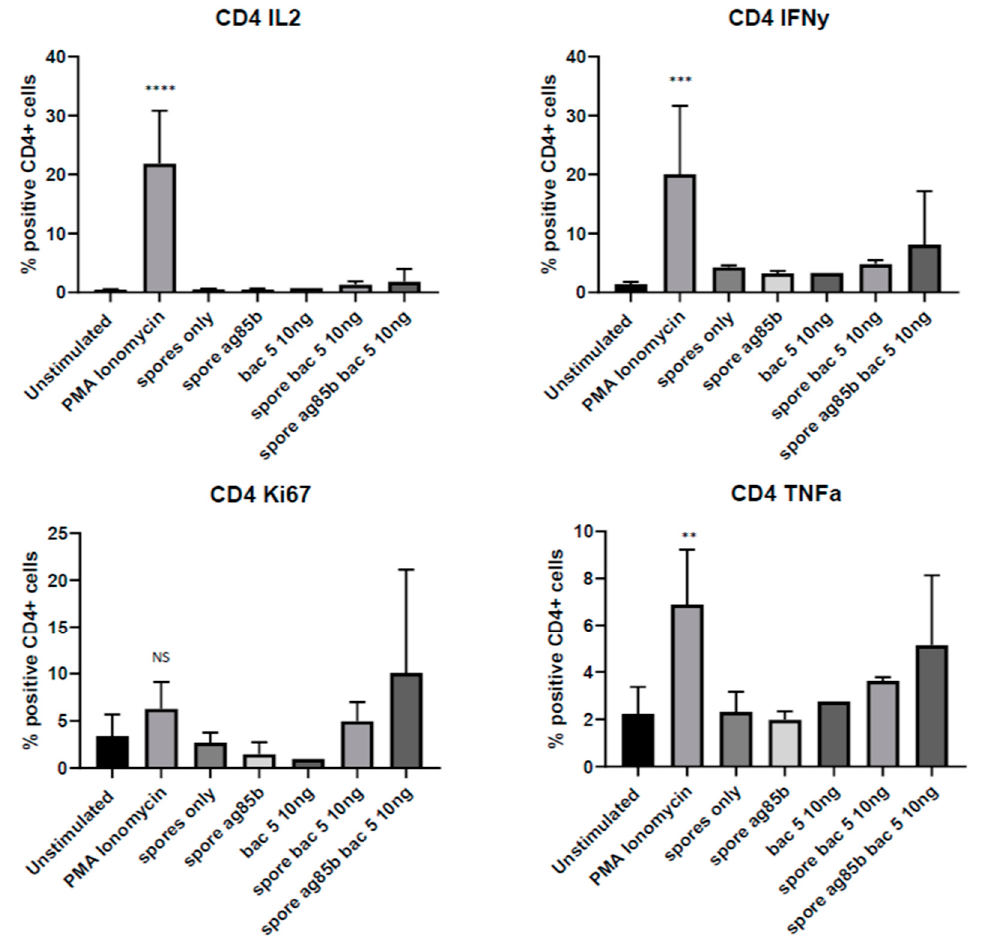
Figure 4. Intracellular Cytokine Production and Proliferation of Stimulated CD4 + Tonsil Mononuclear Cells. Human tonsil mononuclear cells were prepared as described and stimulated with different adjuvant combinations including B. subtilis spores (at a ratio of 100:1 to tonsil cells); Ag85B (5 µg/mL) and/or a titration of Bac5 peptide. Phosphomolybdic acid (PMA) ionomycin was used as a positive control. Cells were permeabilised with 0.5% saponin and intracellular cytokines stained using directly labeled target-specific IgG antibody. Fluorescence intensity was established on viable cells using flow cytometry. The percentage of CD4 + cells colocalising with positive fluorescence from either IL-2 + , IFN γ + , Ki67 + or TNF α + positive populations are displayed. Statistical analysis was performed using one-way ANOVA (**** = p < 0.0001, *** = p < 0.001, ** = p < 0.01, NS = No Significance).